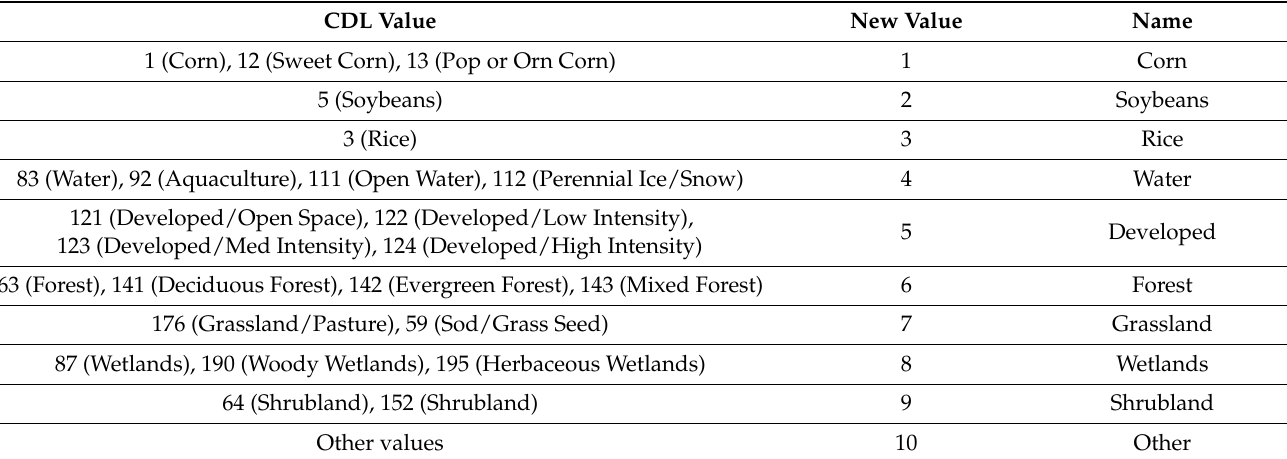
Table 1. Crop category, value, and number of samples. CDL Value New Value